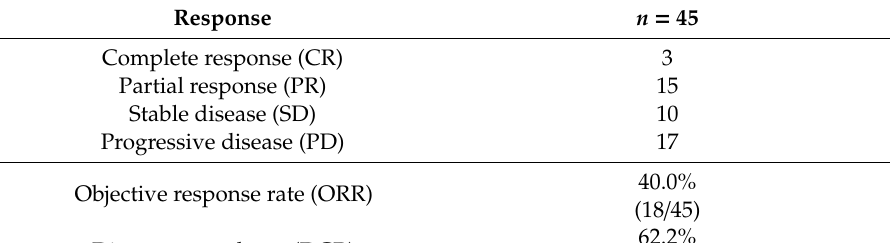
Table 2. Response to lenvatinib at 8–12 weeks after lenvatinib induction.